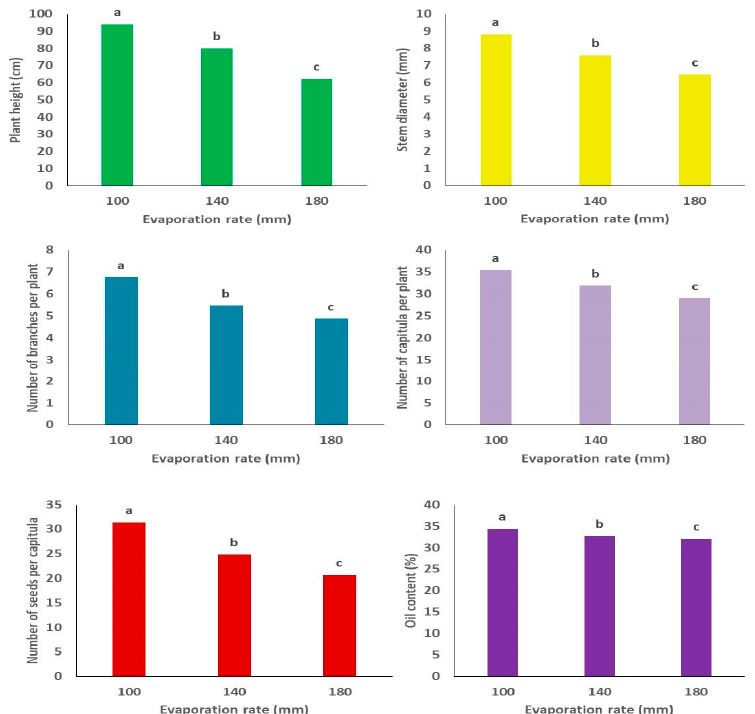
Figure 1. Main effects of irrigation levels on safflower traits. Different letters within each variable indicate significant differences at p < 0.05 based on Fisher’s protected LSD test.